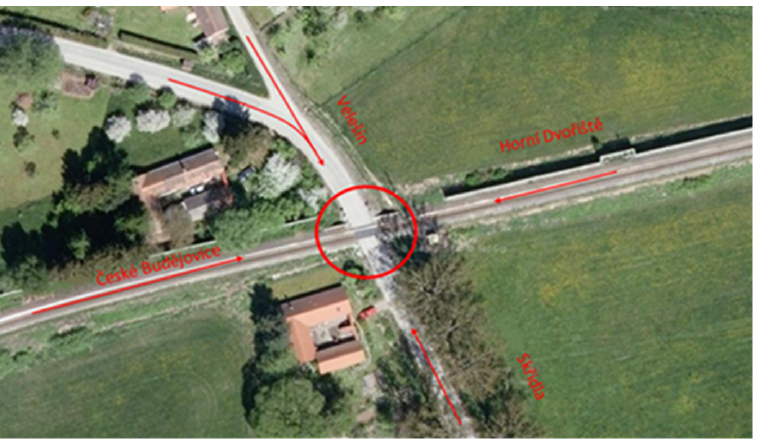
Figure 7. Rail crossing No. P5567. Table 5. Rail Crossing No. P5567–basic